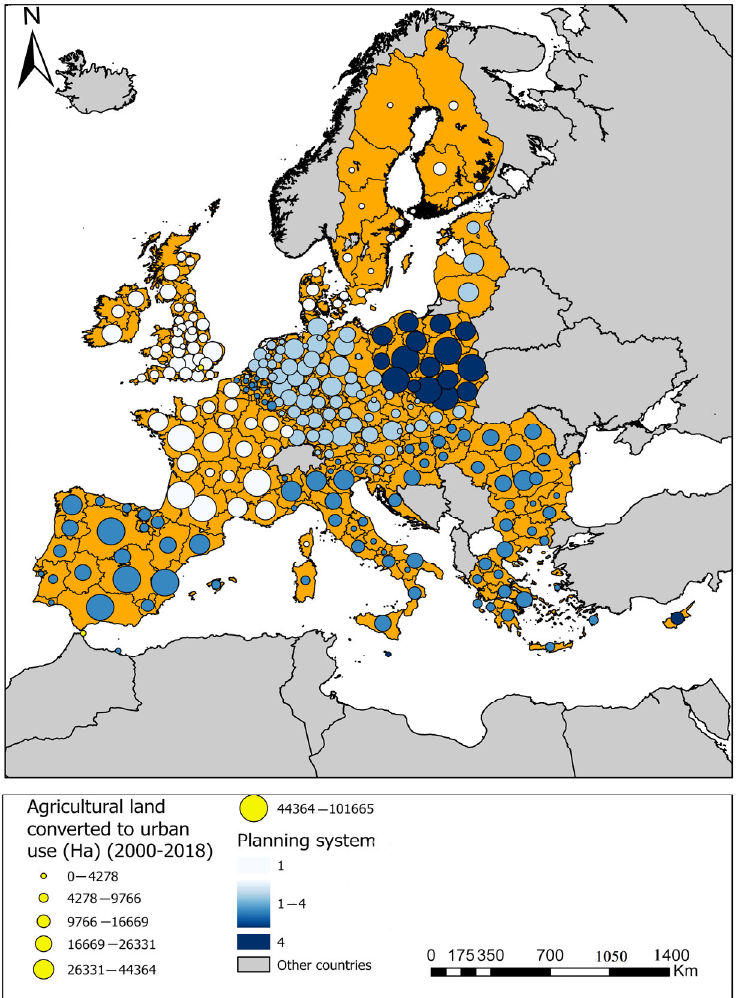
Figure 2. Distribution of agricultural land converted to urban use at the NUTS2 level in the EU27+UK between 2000 and 2018. Source: The Figure was created by the authors based on CLC data from EEA [21]. Note: Planning systems (from light blue to dark blue): 1: State-led systems; 2: Market-led neo-performative systems; 3: Conformative systems; 4: Misled performative systems.